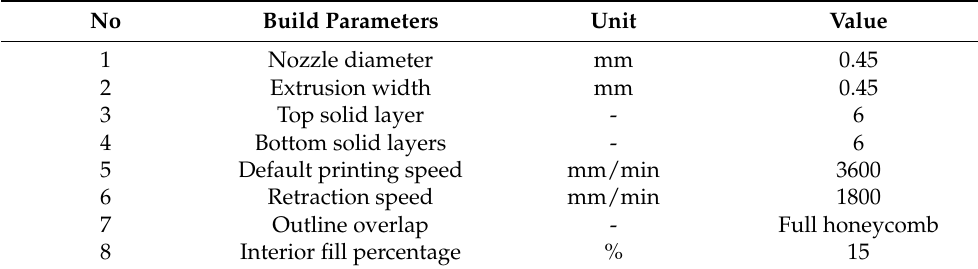
Table 5. Fused filament fabrication (FFF) build